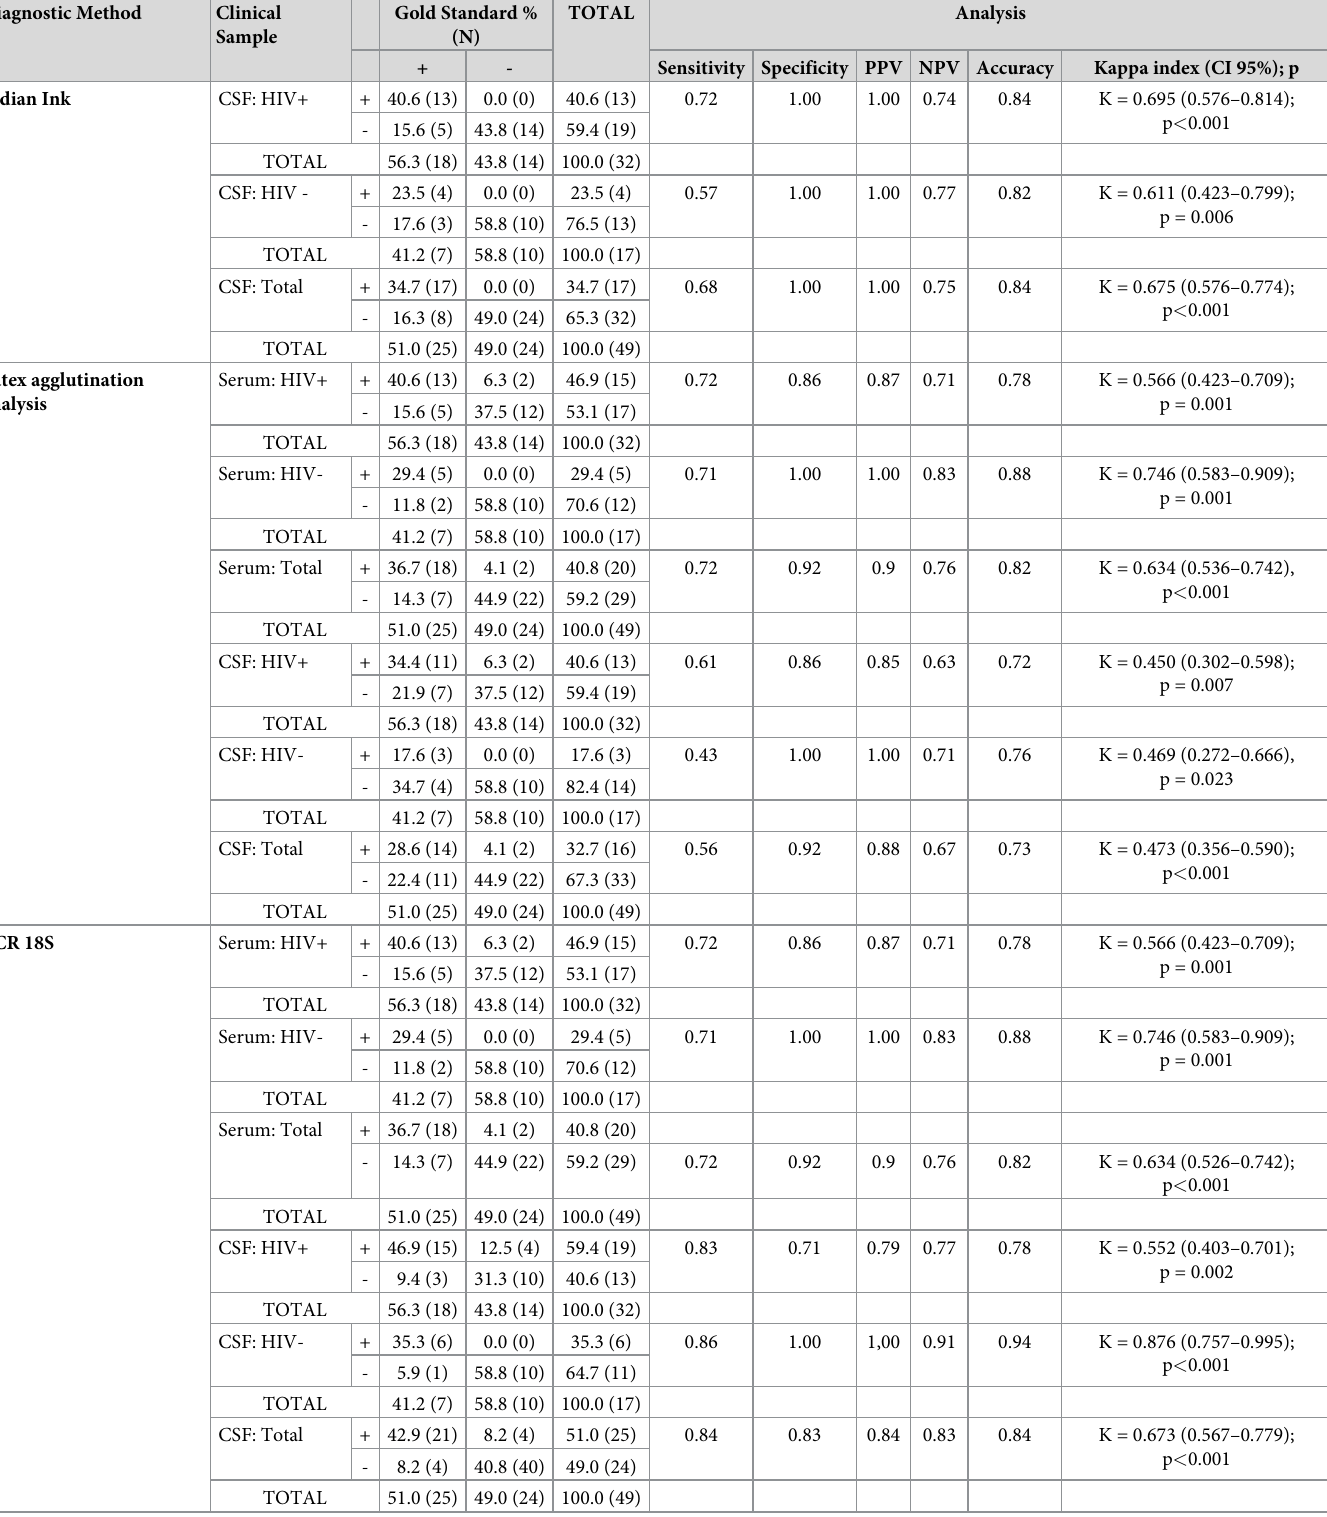
Table 4. Accuracy of the diagnostic techniques for the diagnosis of